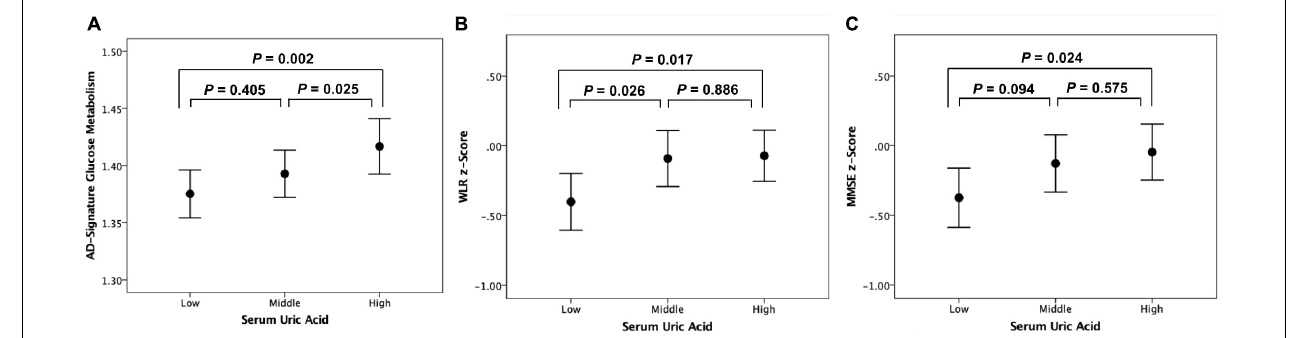
FIGURE 2 | Error bar charts with standard error bars displaying (A) AD-signature cerebral glucose metabolism, (B) WLR z-scores, and (C) MMSE z-scores before adjustment for cerebral glucose metabolism according to serum uric acid strata in non-demented participants. Abbreviations: AD, Alzheimer’s disease; WLR, Word List Recall; MMSE, Mini-Mental State